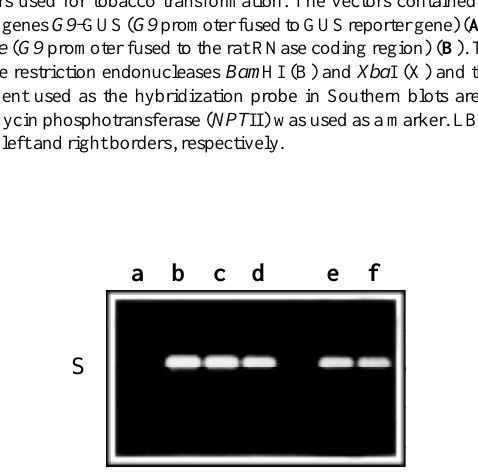
Figure 2 - Polymerase chain reaction gel of tobacco clones transformed with G9- GUS. Lanes a , Non-transformed plant, negative control; b-f , GUS- positive transgenic clones. The arrowhead shows a 710-bp fragment ampli- fied with the GUS primers ( DR 37/48 ) furnished by Agracetus